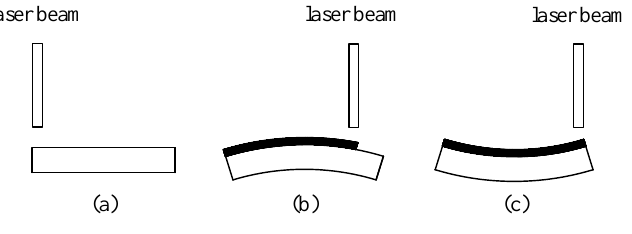
Figure 7. Schematic of the deformation process of thin-walled parts. ( a ) Before the laser cladding; ( b ) During the laser cladding; ( c ) After the laser cladding.